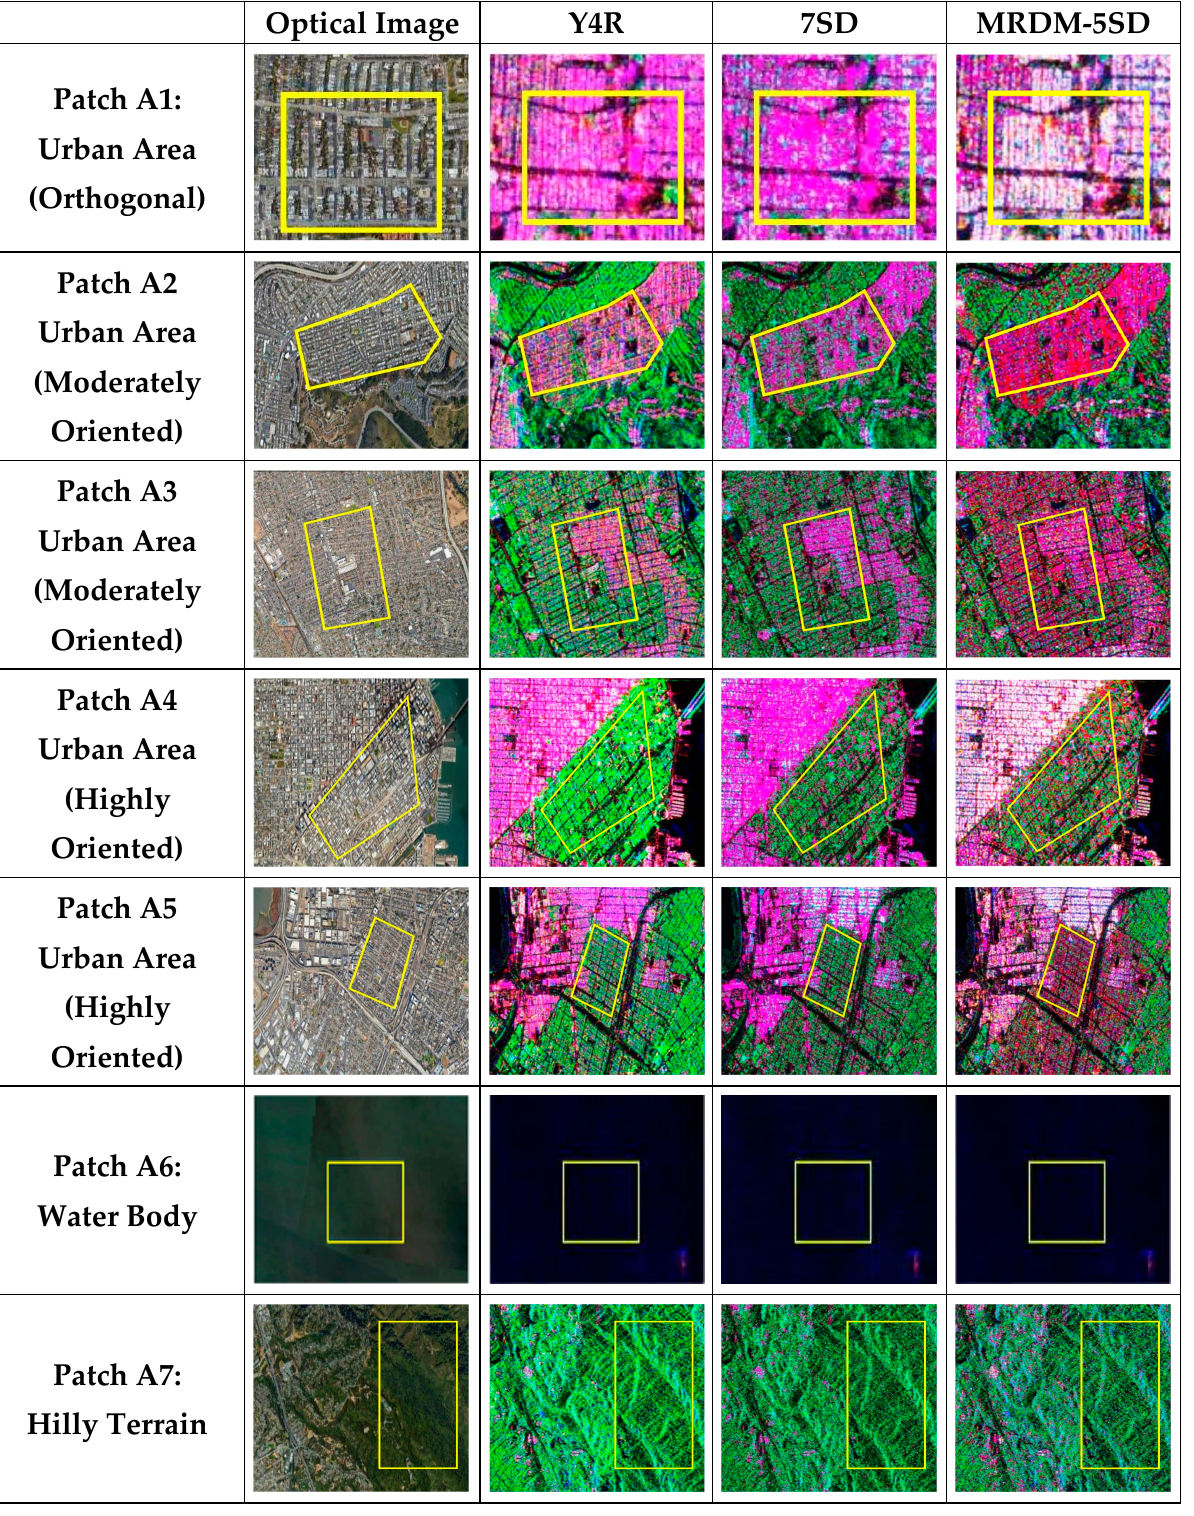
Figure 10. Enlarged view of Patch A1 (orthogonal urban area), Patch A2, A3 (urban areas with moderate orientation angles), Patch A4, A5 (urban areas with large orientation angles), Patch A6 (water body), Patch A7 (hilly terrain) by Y4R, 7SD and MRDM-5SD (RGB component: red: double-bounce scattering, green: volume scattering, blue: surface scattering).